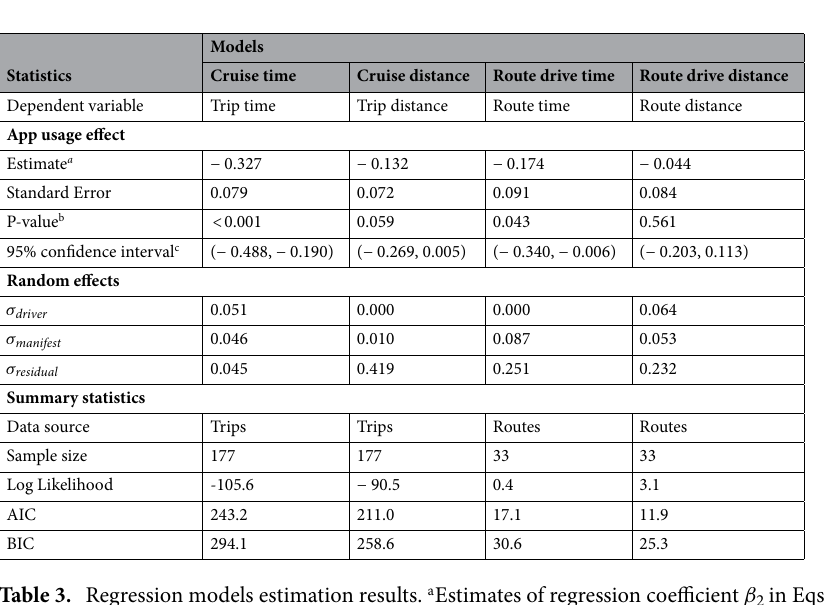
Table 3. Regression models estimation results. a Estimates of regression coefficient β 2 in Eqs. (1–4) above. b Computed by Likelihood Ratio Test. c Computed by profiling the likelihood of the models using the profile() function in lme4 package 32 .